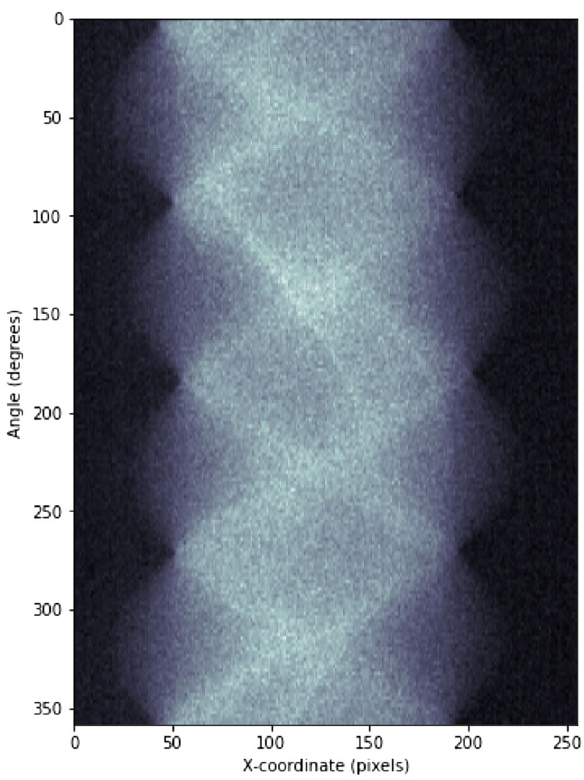
Figure 6. Example of a sinogram from the projections taken at energy